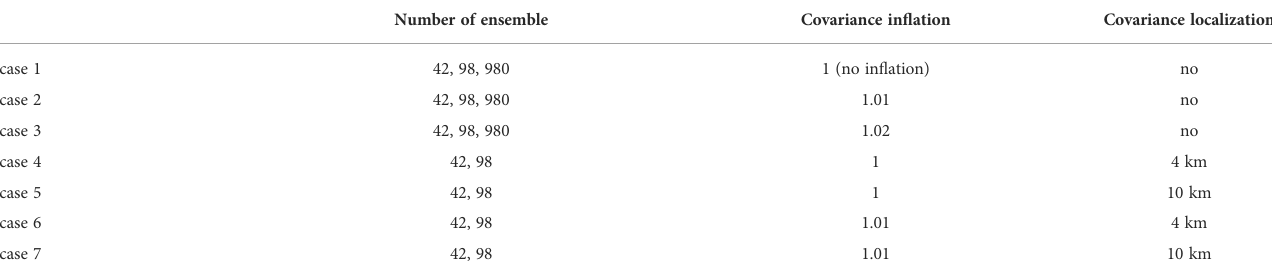
TABLE 3 Test cases of data